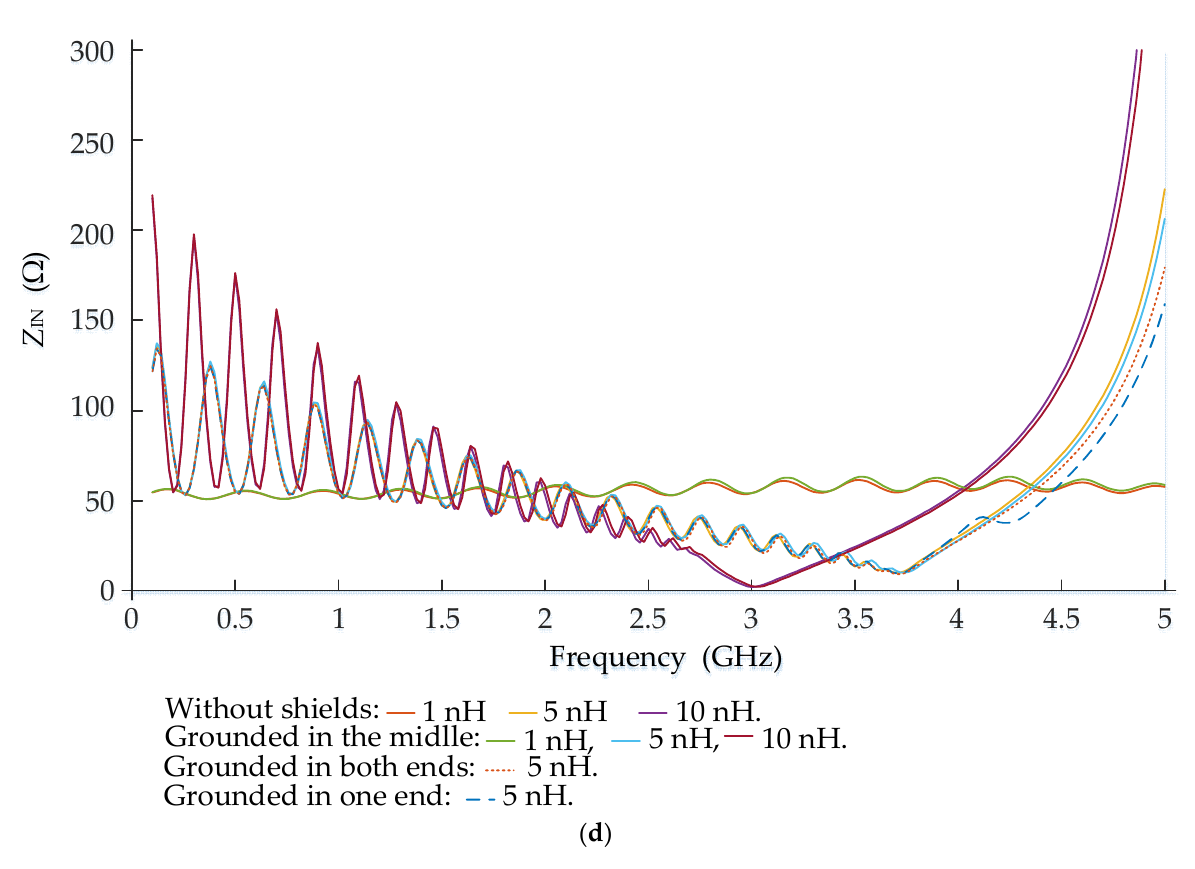
Figure 5. Computer-based modeling results from Sonnet ® of the ( a ) S 21 , ( b ) S 11 , ( c ) t d , and ( d ) Z IN characteristics of the hybrid meander structures without and with additional shields grounded in the middle, one end, or both ends when the lumped inductive elements obtain values of 1, 5, and 10 nH.